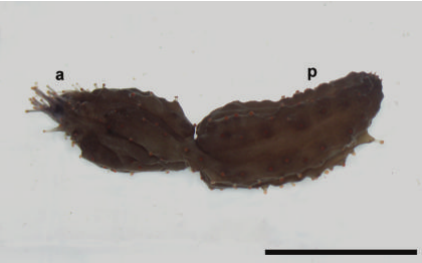
Figure 1: Twisting of Cladolabes schmeltzii during fission. a: anterior part; p: posterior part. Scale bar 2